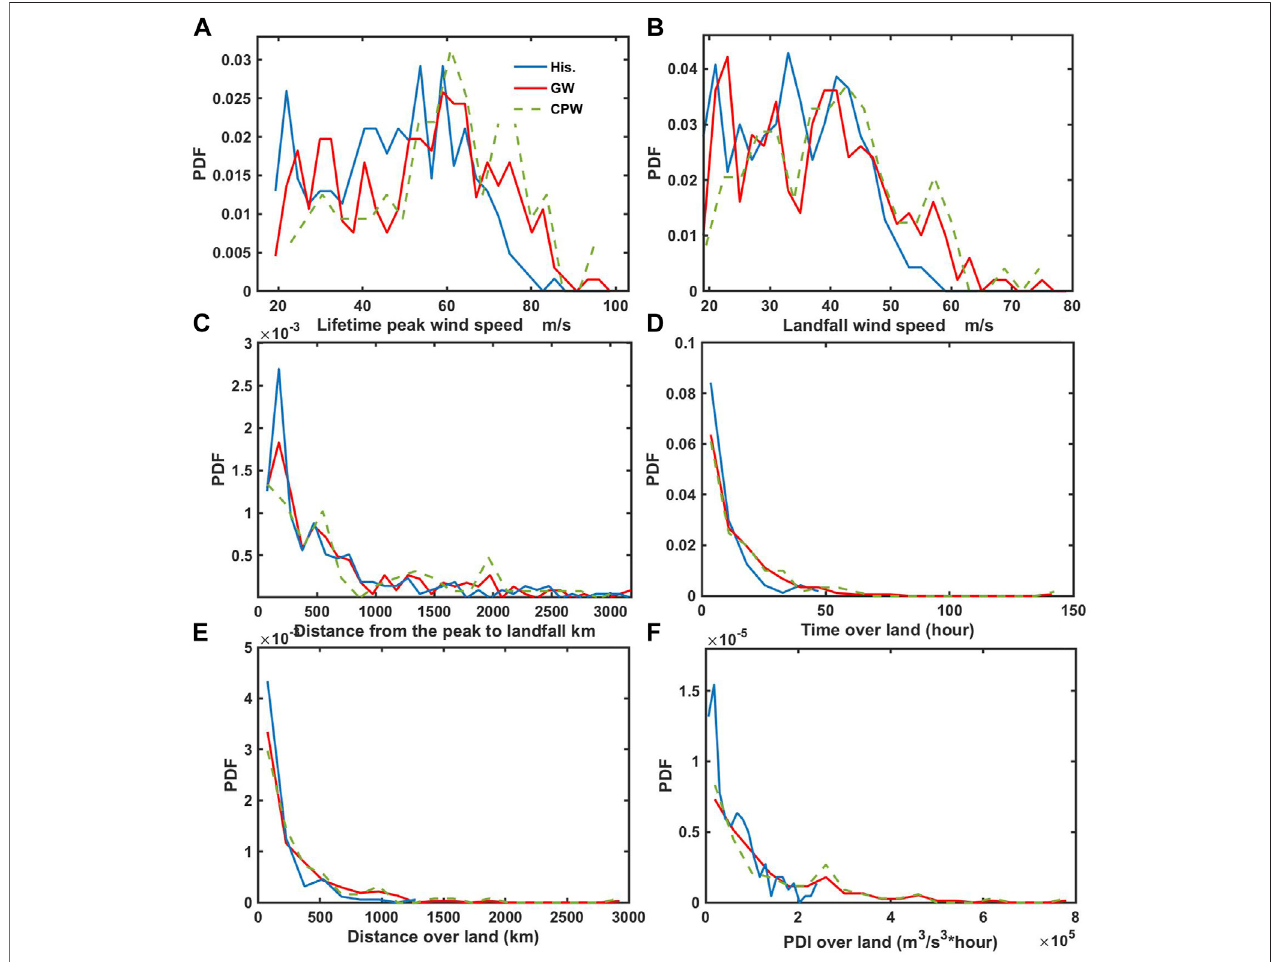
FIGURE 8 | MRI-AGCMs simulated and projected PDFs changes of WNP TC and TC inland impacts. (A – C) are the PDFs changes of TC lifetime peak intensity, landfall intensity, and D pl , respectively. (D – F) are the changes of PDFs of sustaining time, distance travelled, and PDI over land, respectively. Blue lines and red lines represent data in the present-day (1979 – 2003) and global warming condition ensemble mean (2075 – 2099) according to RCP8.5 scenario, respectively, while dashed green lines represent data in the CP warming